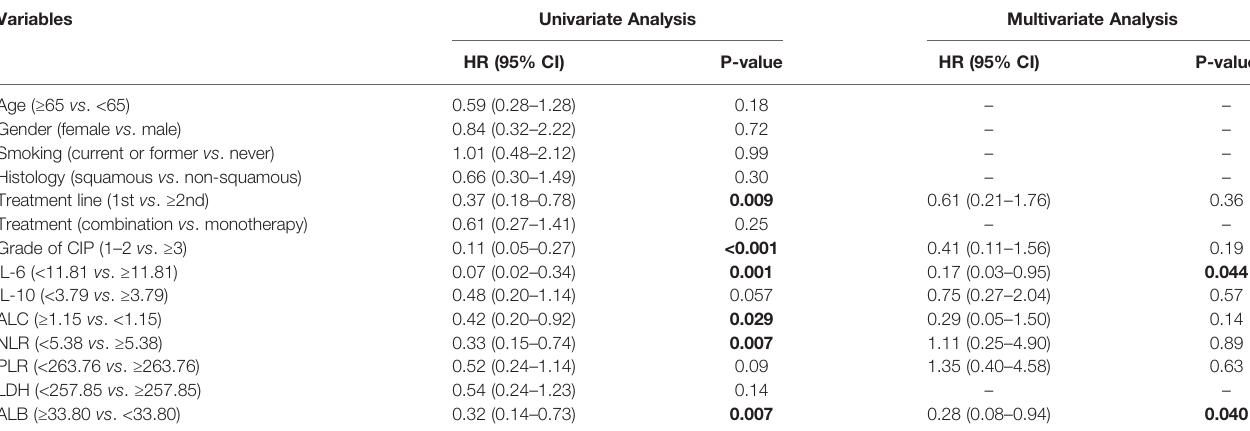
TABLE 4 | Cox proportional hazards regression analysis of clinical factors associated with overall survival of CIP